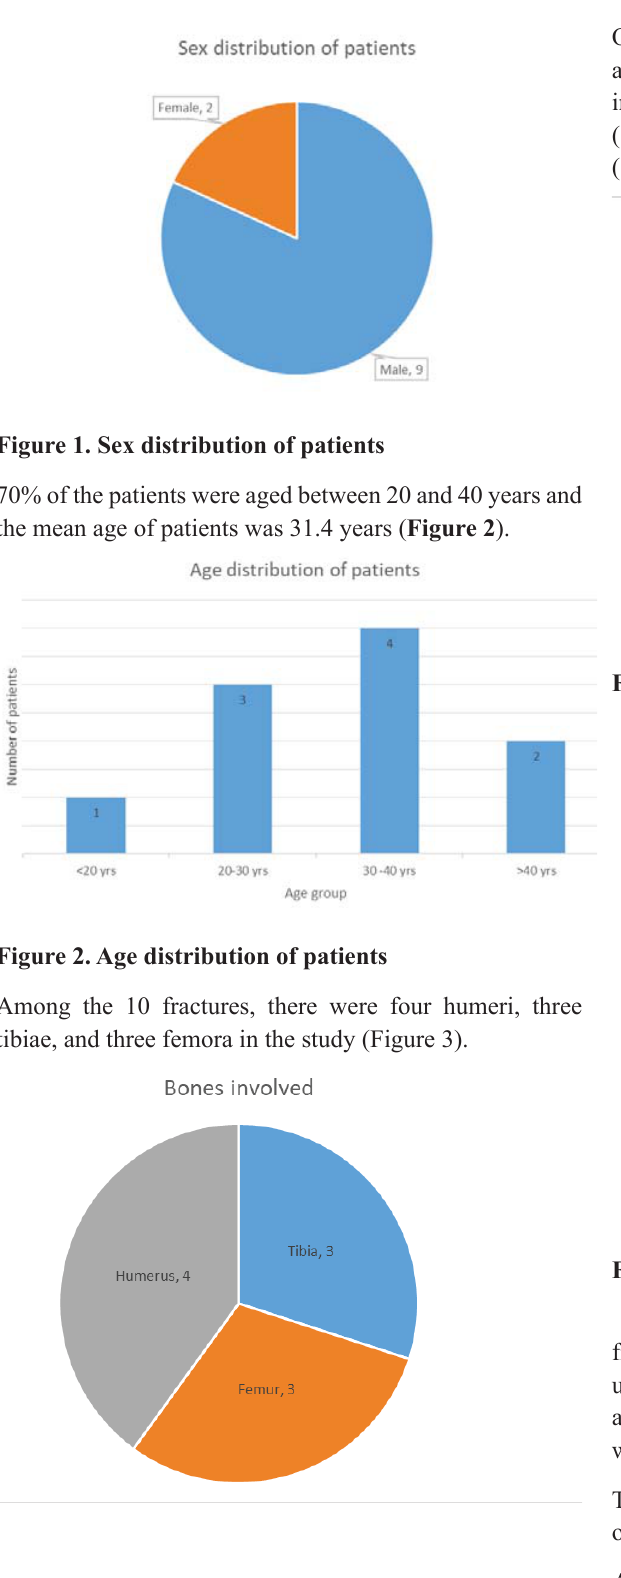
Figure 3. Bones involved